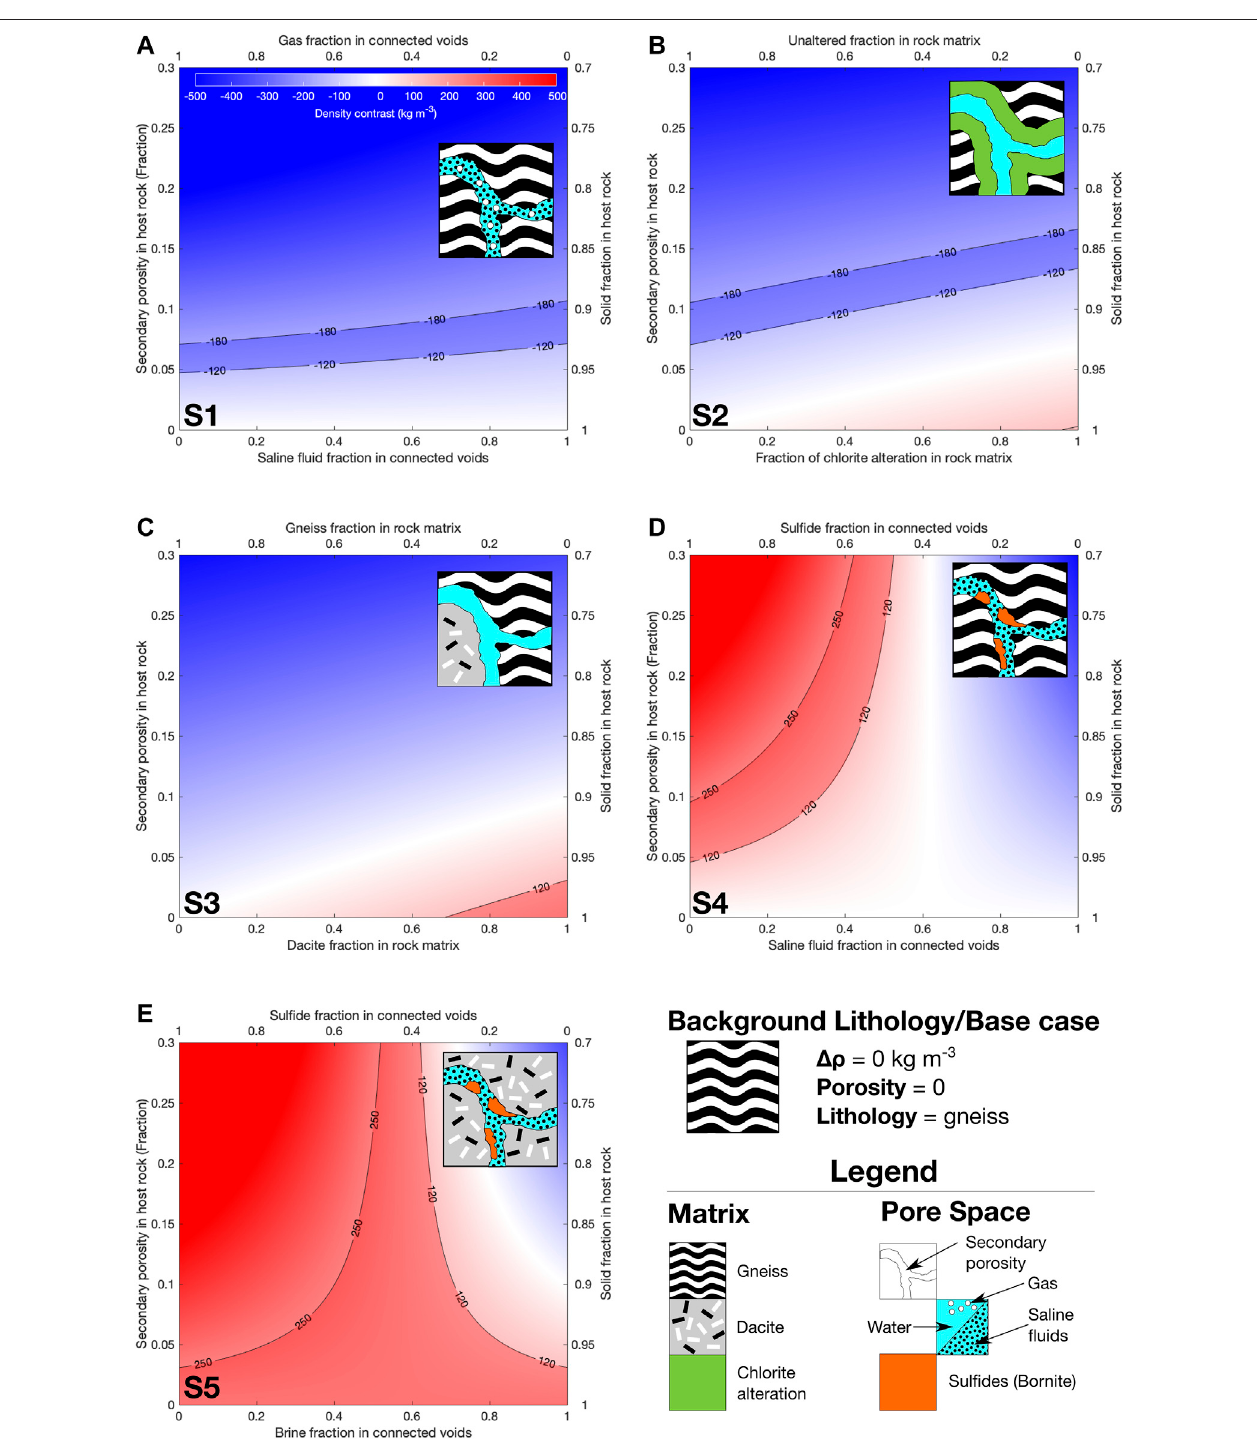
FIGURE 10 | Parameter exploration for range of best- fi t density contrast models. Fill colors correspond to calculated density contrasts for the combination of components indicated on the x and y axes. The shaded areas in between the black contour lines show the range of acceptable density contrasts (positive (cid:1) red and negative (cid:1) blue). Each sub- fi gure includes an explanatory cartoon, with the components explained in the legend in the lower right hand corner of the main fi gure. The scenarios explored in the sub fi gures are as follows: (A) Secondary porosity vs. saline fl uid/gas content of pore space (B) Secondary porosity vs extent of chlorite alteration (C) Secondary porosity vs dacite/gneiss in rock matrix (D) Secondary porosity vs sul fi de/brine content in gneiss matrix (E) Secondary porosity vs sul fi de/brine content in dacite matrix. Scenario numbers from the text are included in the bottom left-hand corner of each sub fi gure.